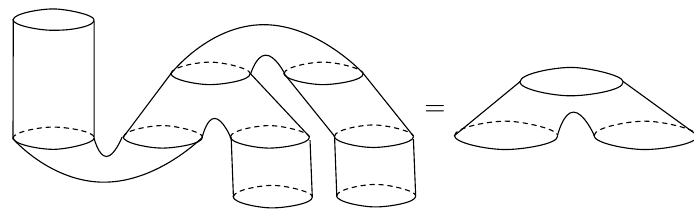
Figure 29 . I is a unit of the product M .